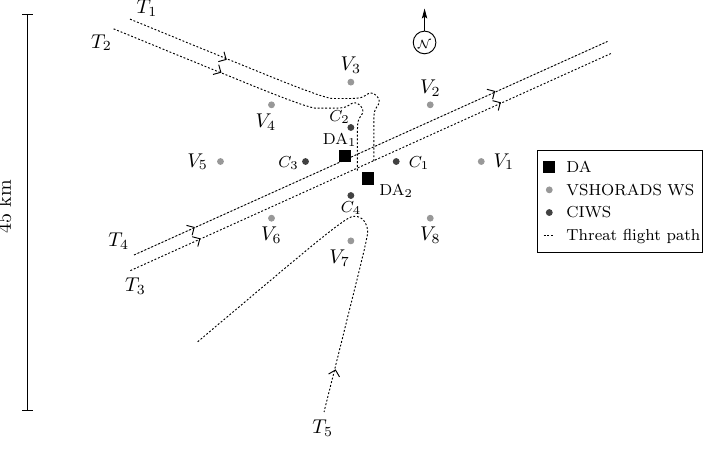
Figure 2: Top view of the simulated GBAD